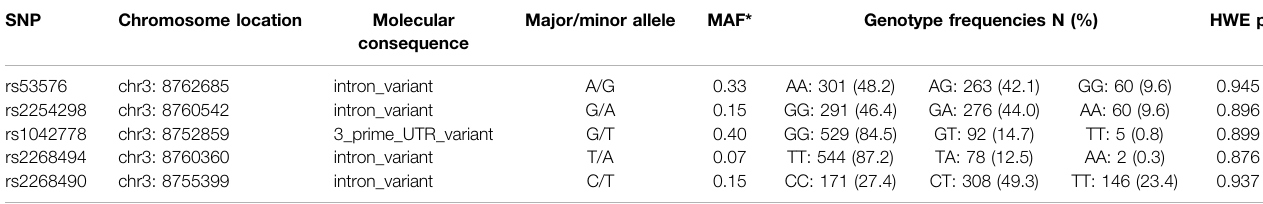
TABLE 1 | OXTR single nucleotide polymorphism